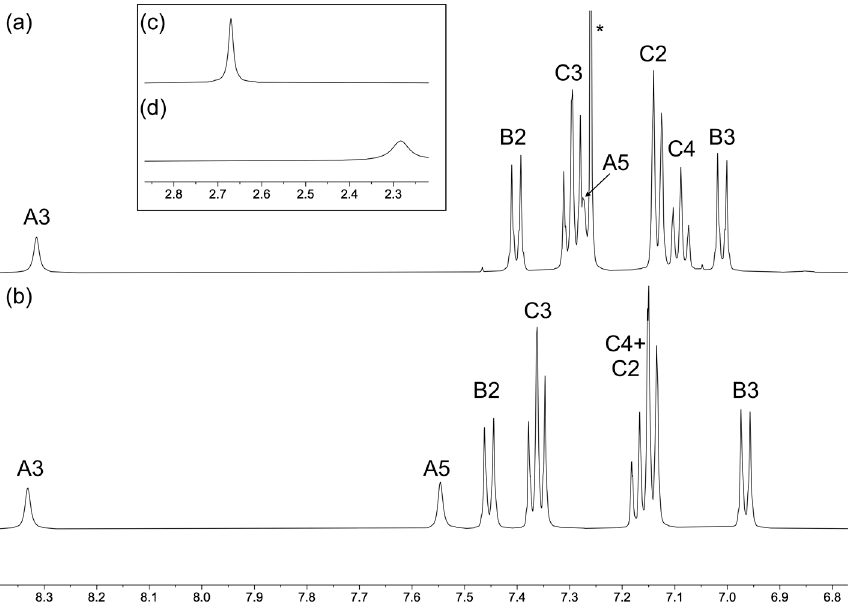
Figure 2. Comparison of the aromatic regions of the 1 H NMR spectra (500 MHz, 298 K) of ( a ) ligand 4 in CDCl 3 and ( b ) [Cu( 4 ) 2 ][PF 6 ] in CD 3 CN. The alkyl regions are shown in ( c ) 4 and ( d ) [Cu( 4 ) 2 ][PF 6 ]. See Scheme 2 for atom labelling. Scale: δ / ppm. * = residual CHCl 3 .